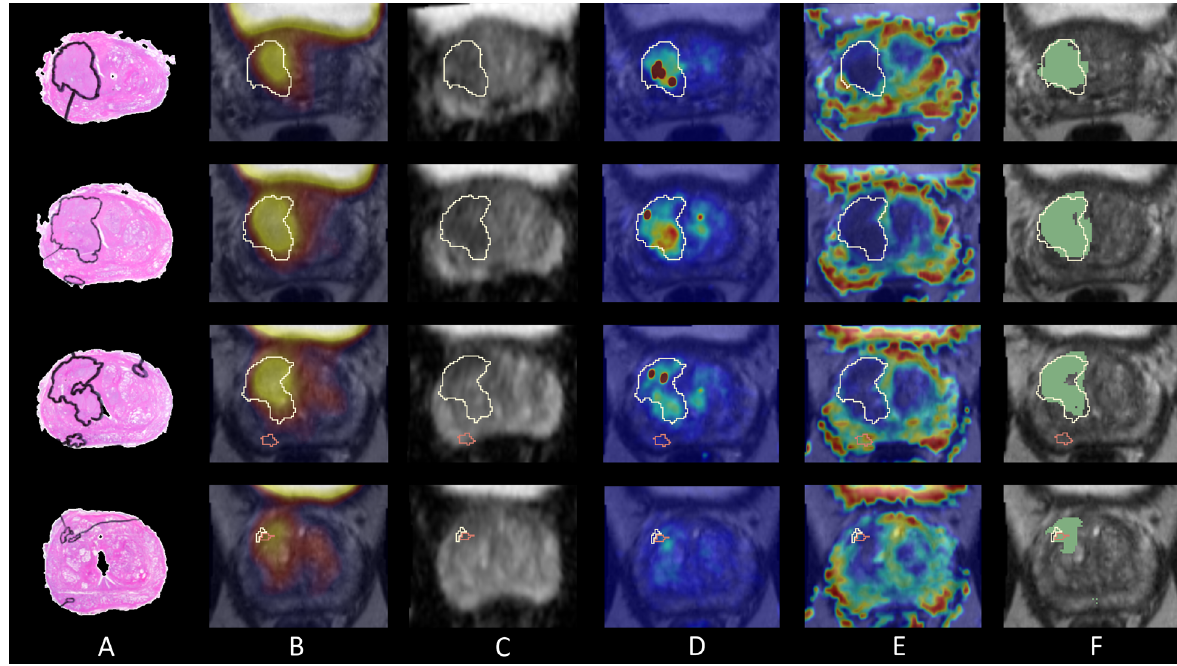
Fig. 4 Results from the best performing patient 26 showing four image slices from top to bottom (base to apex) with: a tumour annotations on histology, b PET and T2w MRI, c the ADC map, d Ktrans map, e TTP map and f the predicted tumour voxels in green overlaid on the T2w MRI, each visualised with the tumour location outline from